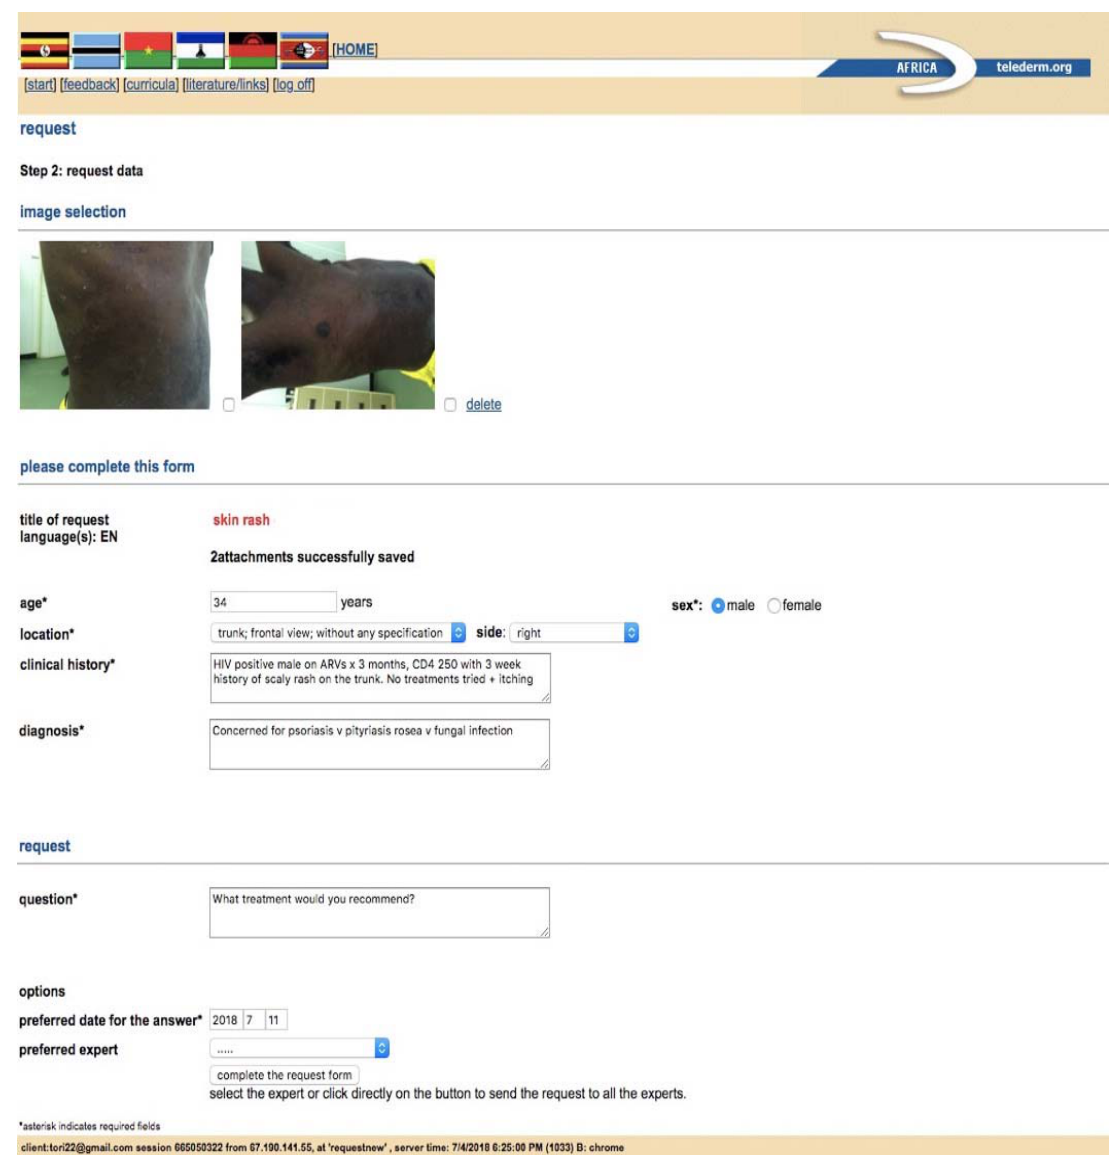
Figure 1. An example of a formal web-based teledermatology platform, the Africa Teledermatology Project, which uses a simple template to collect patient data for consultations.